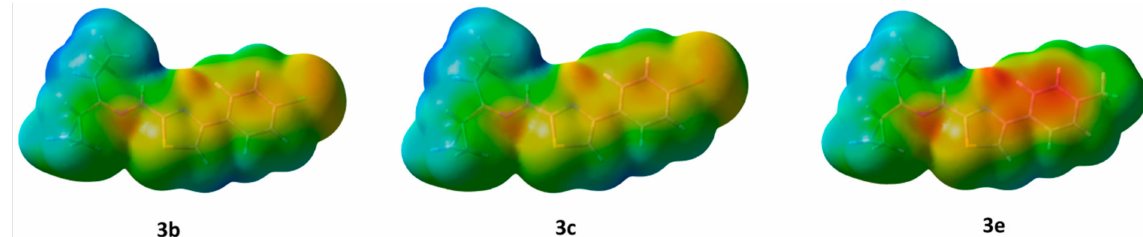
Figure 2. Molecular electrostatic potential (MEP) surfaces for compounds 3b , 3c and 3e